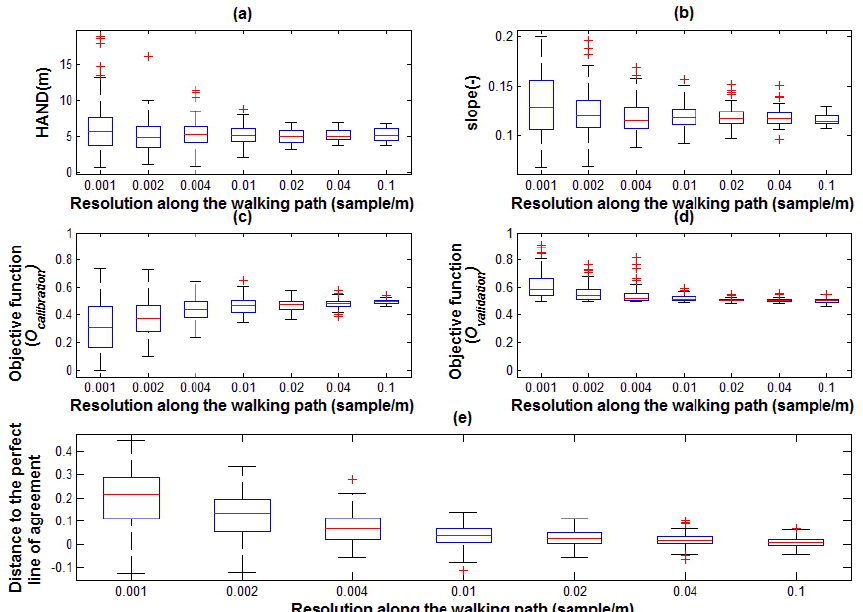
Fig. 11. Behaviour of parameters and objective functions depending on different calibration sample sizes; different sample sizes are shown based on resolution (sample/m) along the walking path (a) the behavior of HAND for different sample sizes (b) behavior of slope for different sample sizes (c) behavior of calibration objective function ( O ) and (d) behavior of validation objective function ( O ) (e) distance of validation points to the line of perfect agreement. The distance is positive for points above the line and negative for the points below the line. Whiskers represent the 1.5 times the interquartile range (IQR) and the red crosses show outliers.